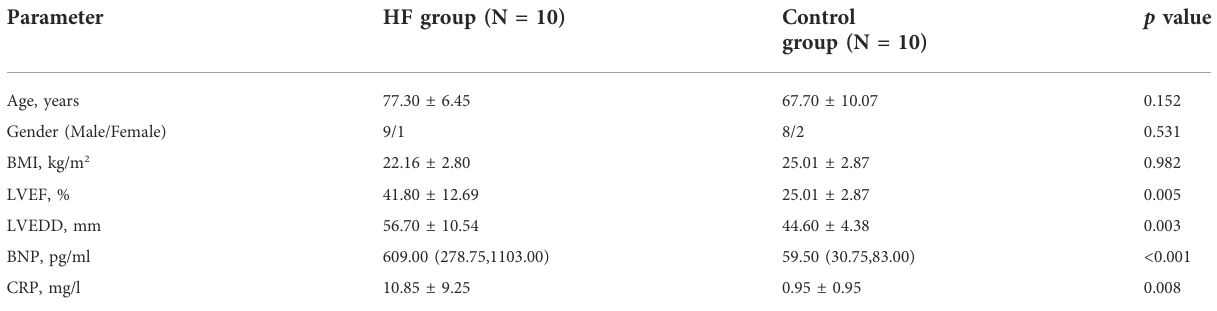
TABLE 1 The clinical characteristics of HF group and control group.